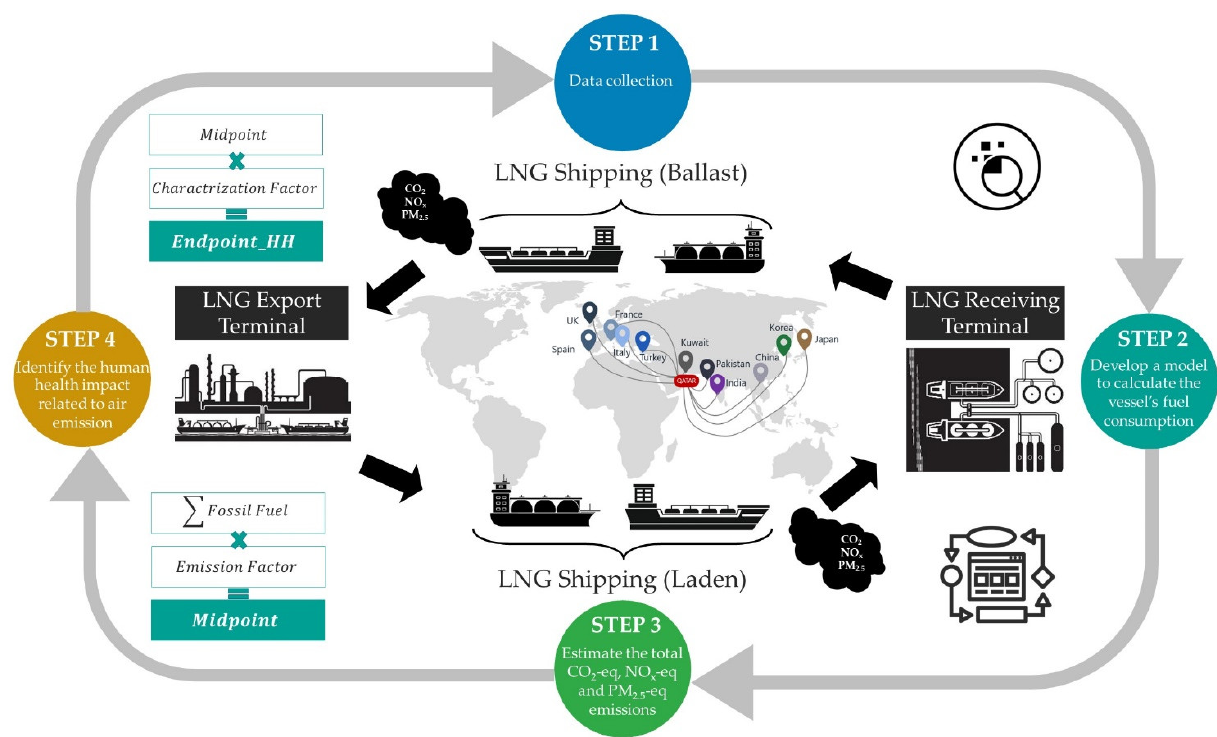
Figure 1. The main four steps of the research methodology.